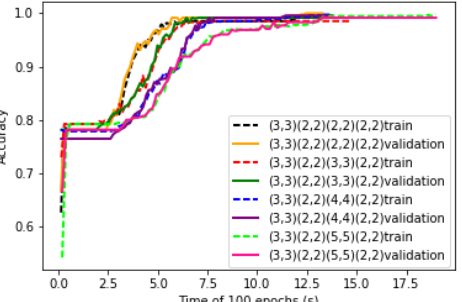
Figure 9. Training and validation curves of LeNet-5 with different sizes of convolutional kernels. Table 6. Comparison of results with different size of convolutional kernels